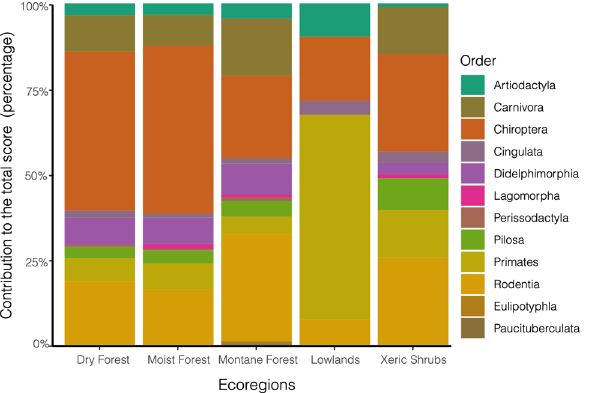
Figure 1. Scores by order per ecoregion. Twelve mammal orders were found in the database records for the five ecoregions that comprise Colombia. The x-axis shows the ecoregions. The y-axis represents the contribution of each mammal taxonomic order to the total score calculated in each ecoregion (see Supplementary Tables for more detail). Chiroptera presents the highest contribution to the Moist and Dry forests, with more than 50% of the total score in both habitats, followed by Rodentia. Similarly, in the Montane forest and Xeric shrublands, the highest scores are shared between Rodentia and Chiroptera order. Primates represents the highest contribution in the Lowlands and an important contribution in the Xeric